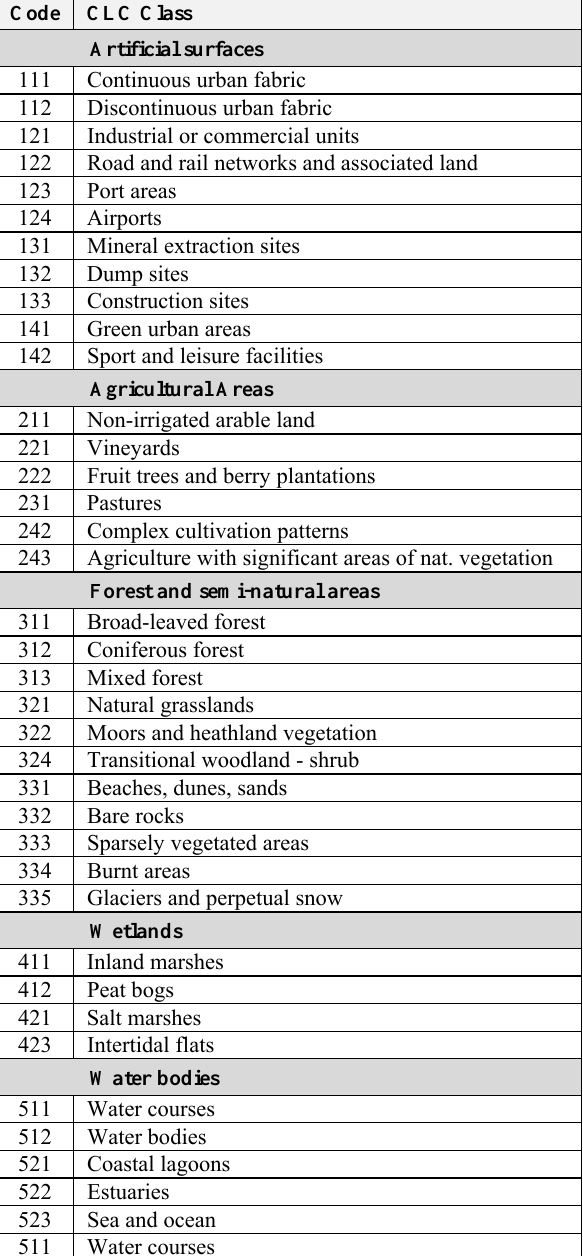
Table 1: The 37 CORINE Land Cover classes for